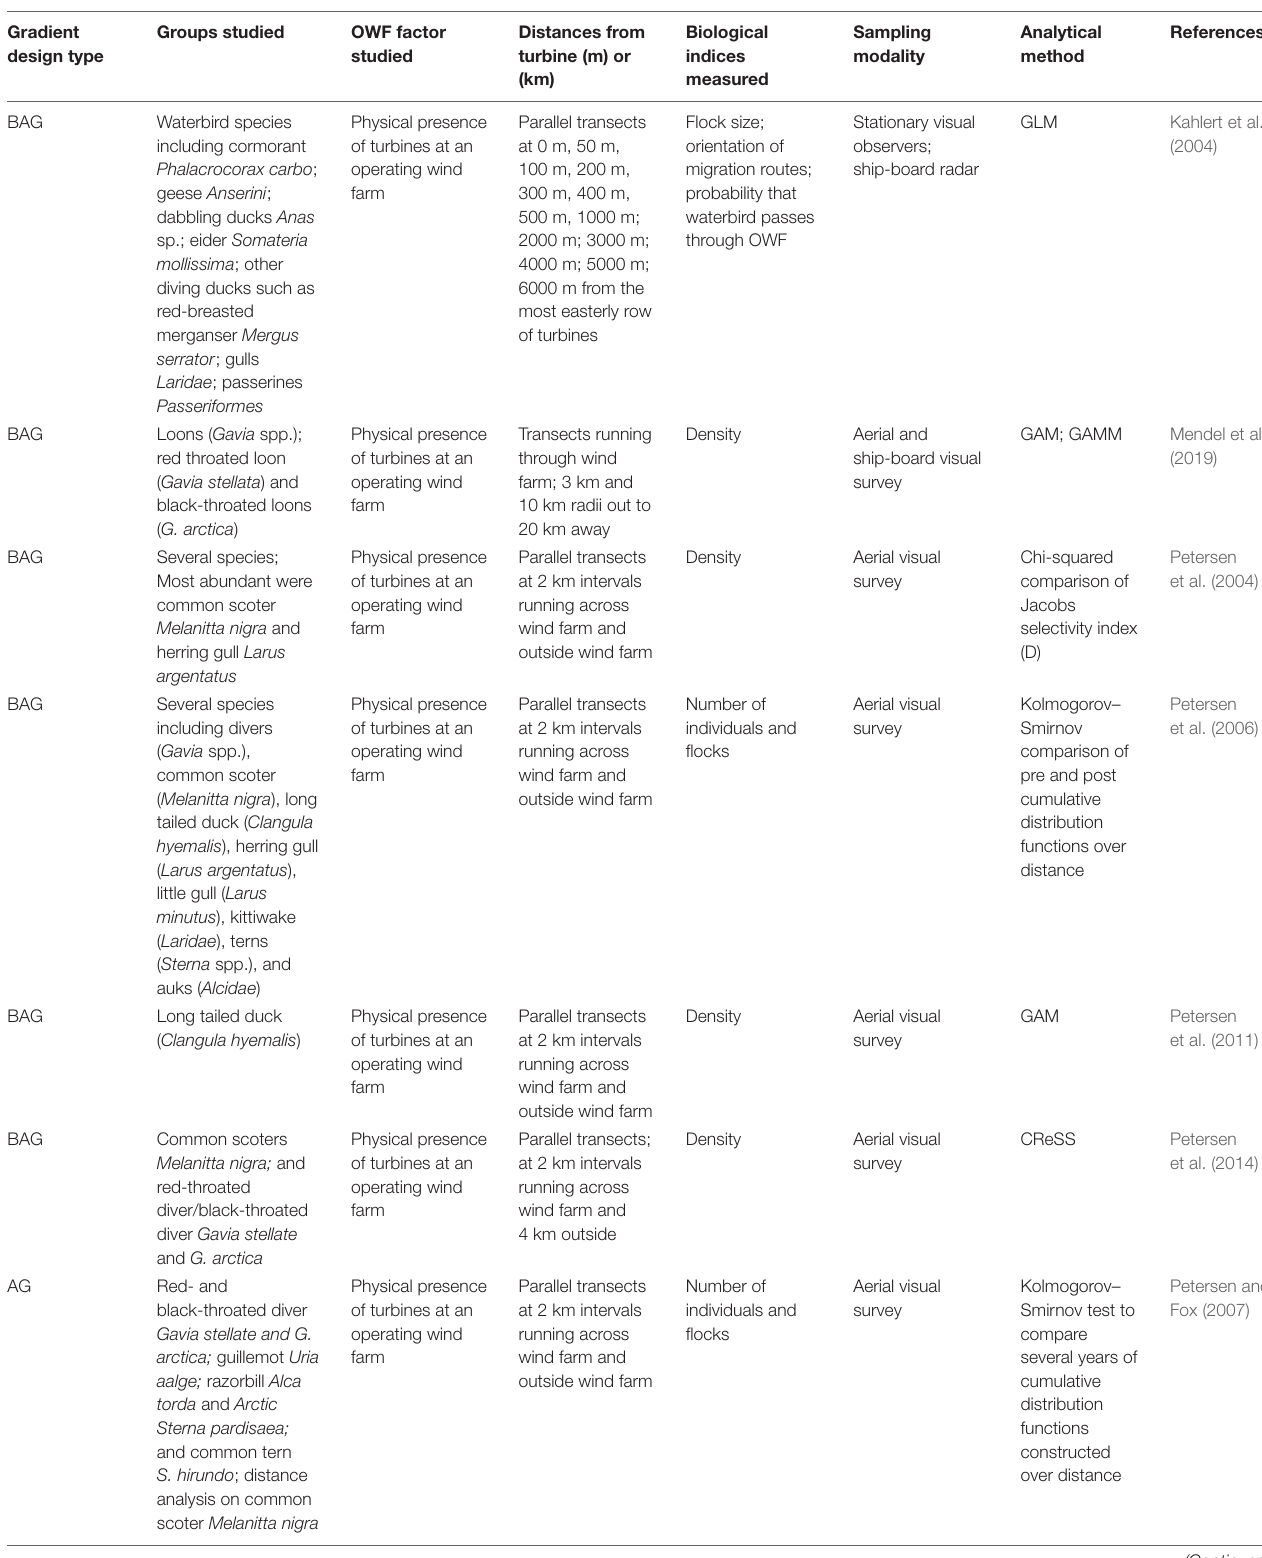
TABLE 5 | Studies of avian species that used a gradient design to examine the effects of OWF development. Gradient design